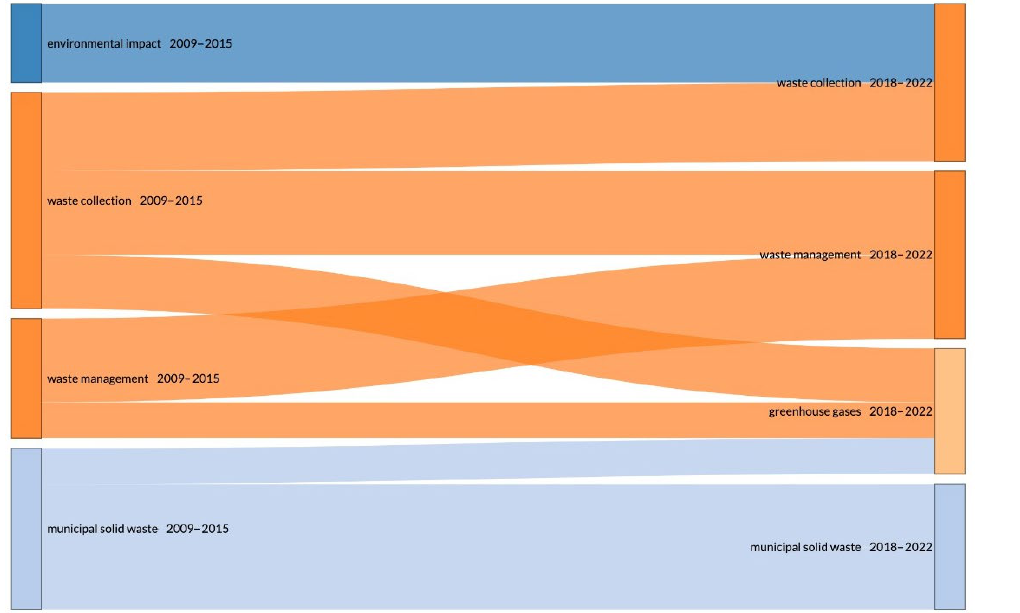
Figure 8. Thematic evolution during the period 2009–2022 using R-studio software and bibliometrix library.